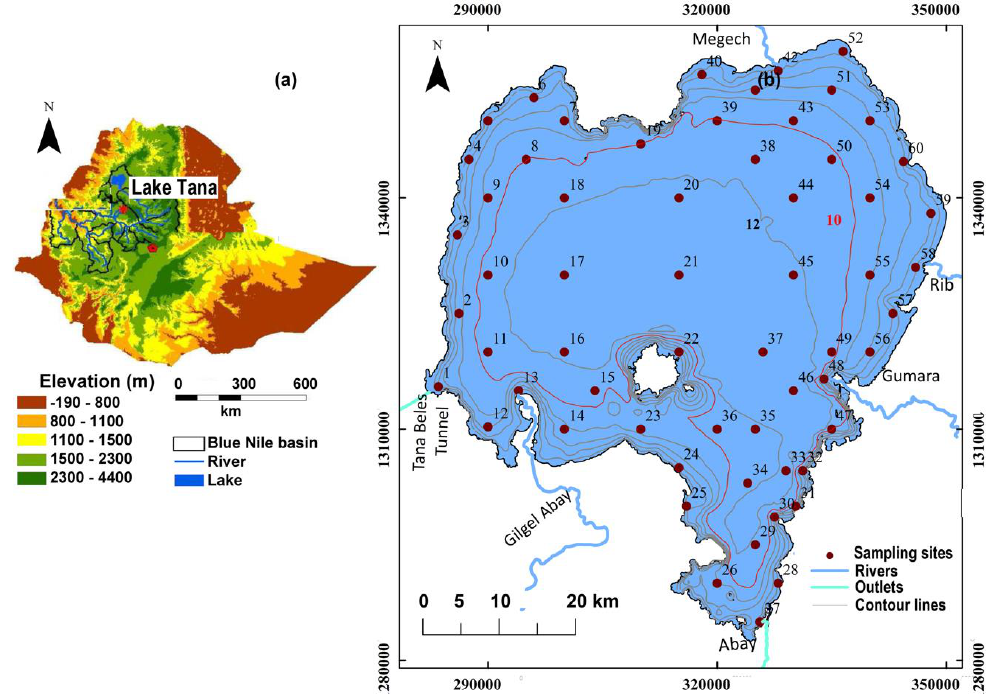
Figure 1. Location map of the study area ( a ). The map of Ethiopia and Ethiopian lakes superimposed on the national geography world map ( b ). Bottom sediment sampling sites on Lake Tana and major inflow – outflow rivers. The contour lines indicate the depth of the lake at 2 m intervals. The red contour is the 10 m depth contour.